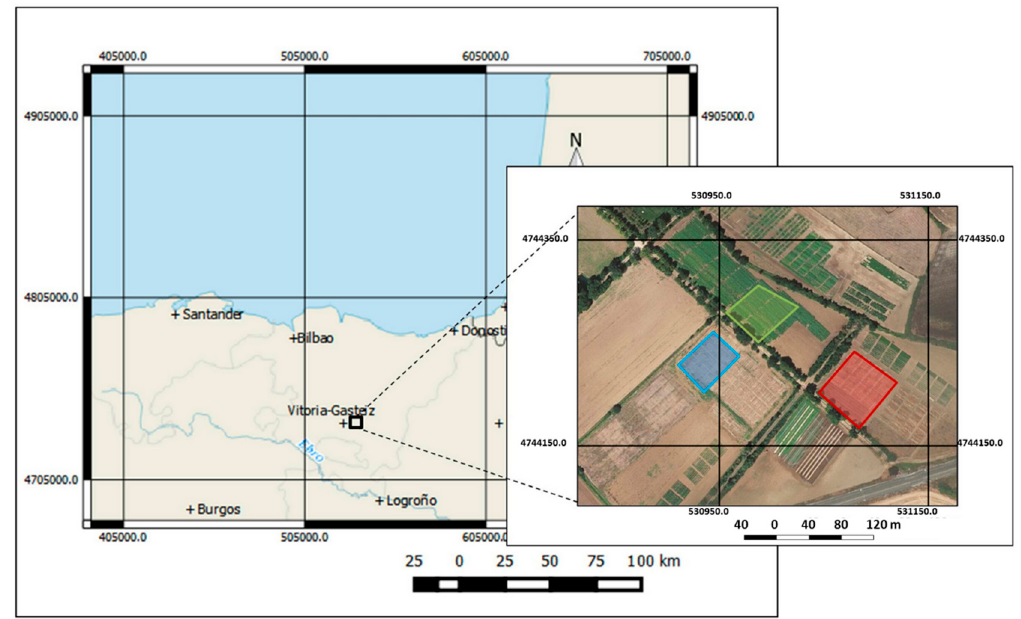
Figure 1. Location of the three field experiments in Arkaute, Araba, Basque Country, northern Spain. The field experiment in 2015 was carried out in the red field. The field experiment in 2016 was carried out in the blue field. The field experiment in 2017 was carried out in the green field.